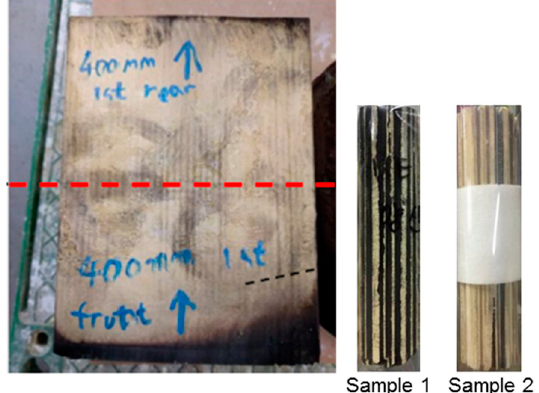
Figure 15. Sampling positions and condition of the used catalyst before and after regeneration.